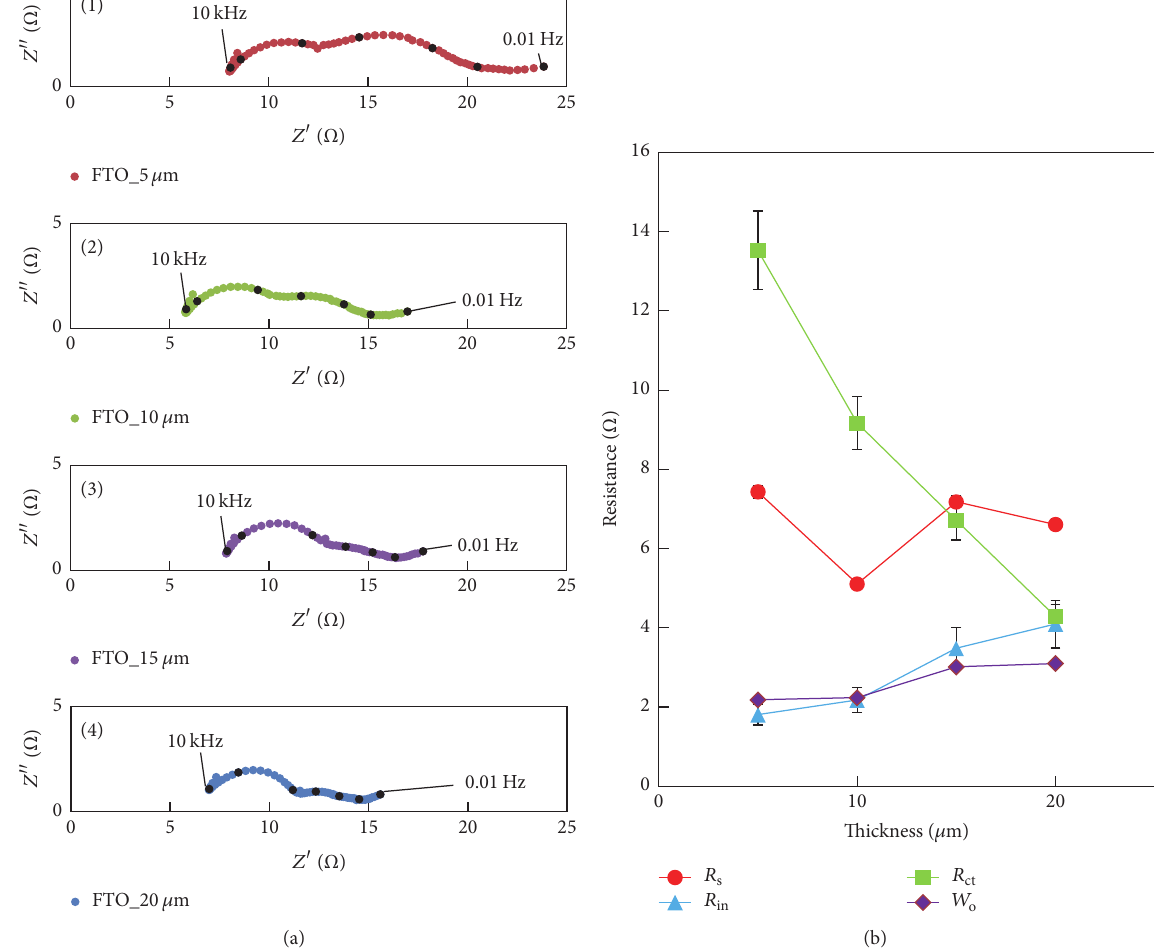
Figure 5: Nyquist plots for porous-FTO/CuS electrodes for various FTO thicknesses. Panels (a)(1), (a)(2), (a)(3), and (a)(4) are the results for FTO thicknesses of 5, 10, 15, and 20 𝜇 m, respectively. FTO thickness dependence on the resistance is shown in panel (b). CuS SILAR cycle for all samples was fixed at 20 times. Black dots in panels (a)(1) to (a)(4) indicate the data recorded under each decade of the frequency.